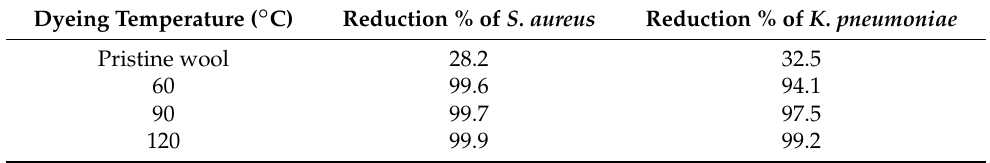
Table 5. Antibacterial capacity of wool fabrics dyed with spent coffee extract for 60 min as a function of dyeing temperature (all dying samples were mordanted with 1 wt % tannic acid aqueous solution). Dyeing Temperature ( ◦ C)